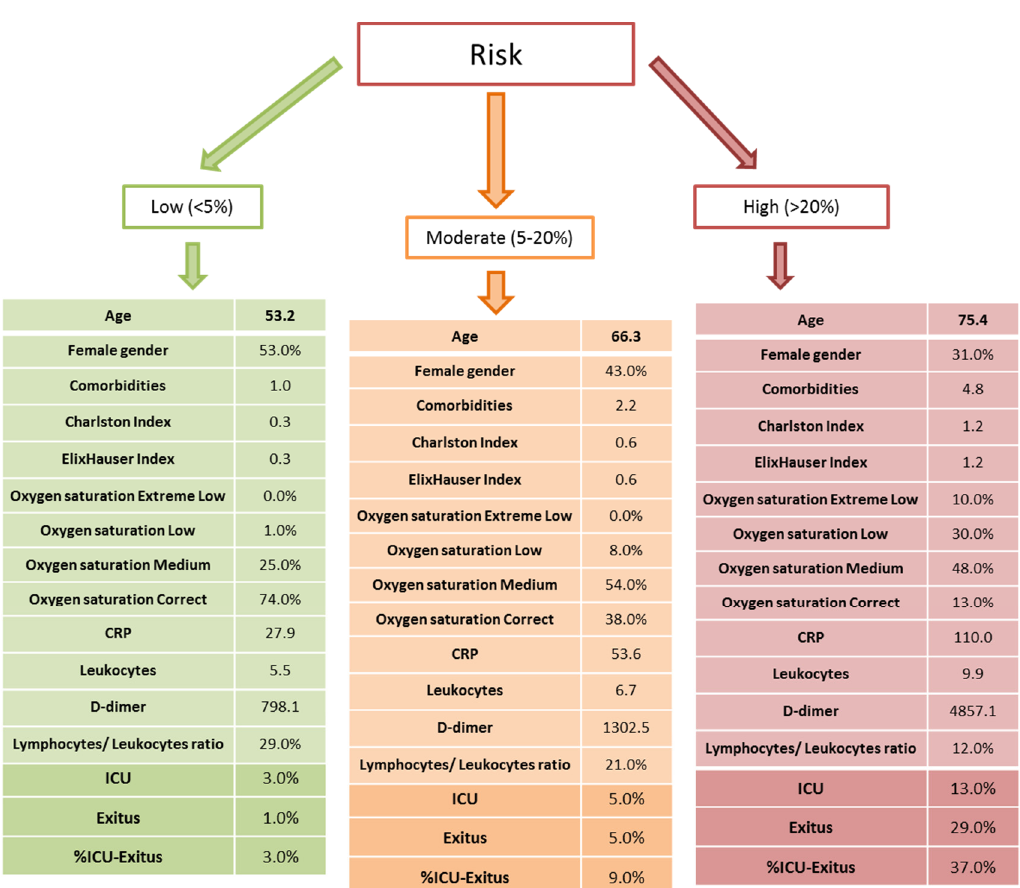
Figure 1. Graphic representation to classify the importance of the study variables in relation to admission to the ICU and death . Three levels of risk are described in this model: low (<5%), moderate (5–20%), and high (>20%). The results are expressed as mean (standard deviation). CRP = C-reactive protein mean, ICU = intensive care unit.